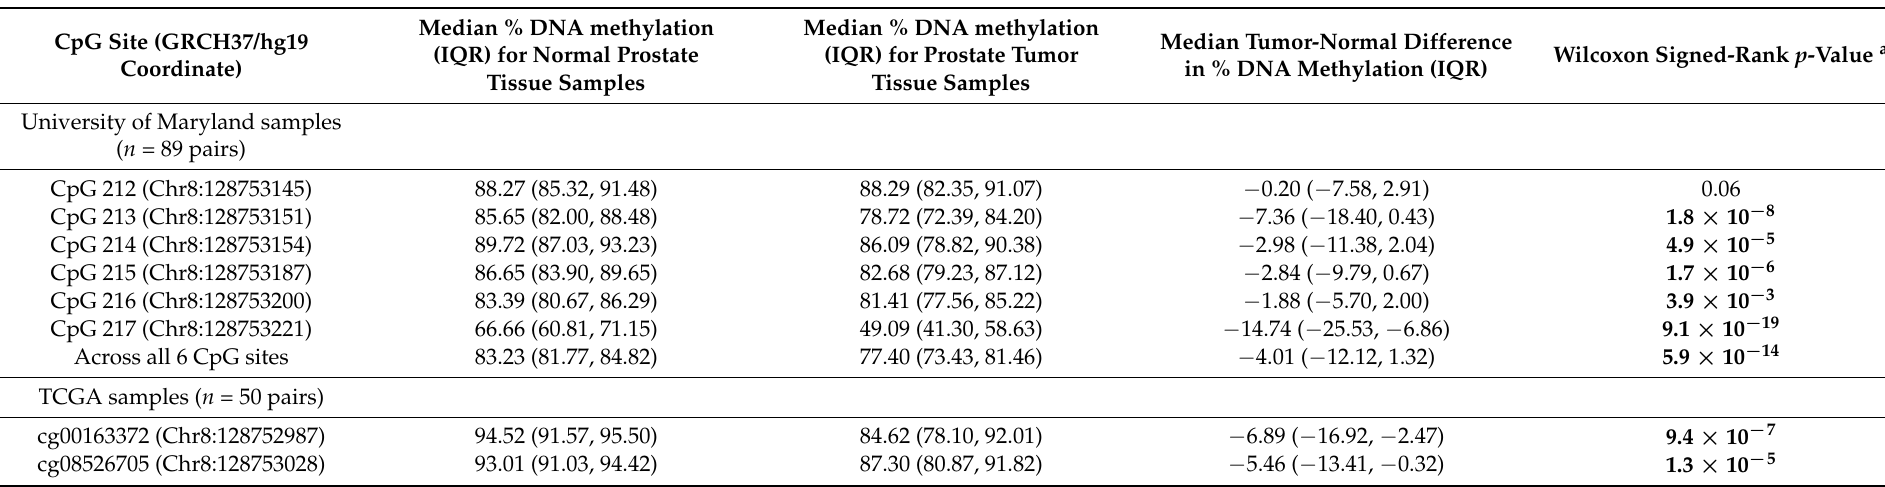
Table 2. Tumor–normal prostate tissue differences in % DNA methylation for MYC CpG sites in the University of Maryland and TCGA